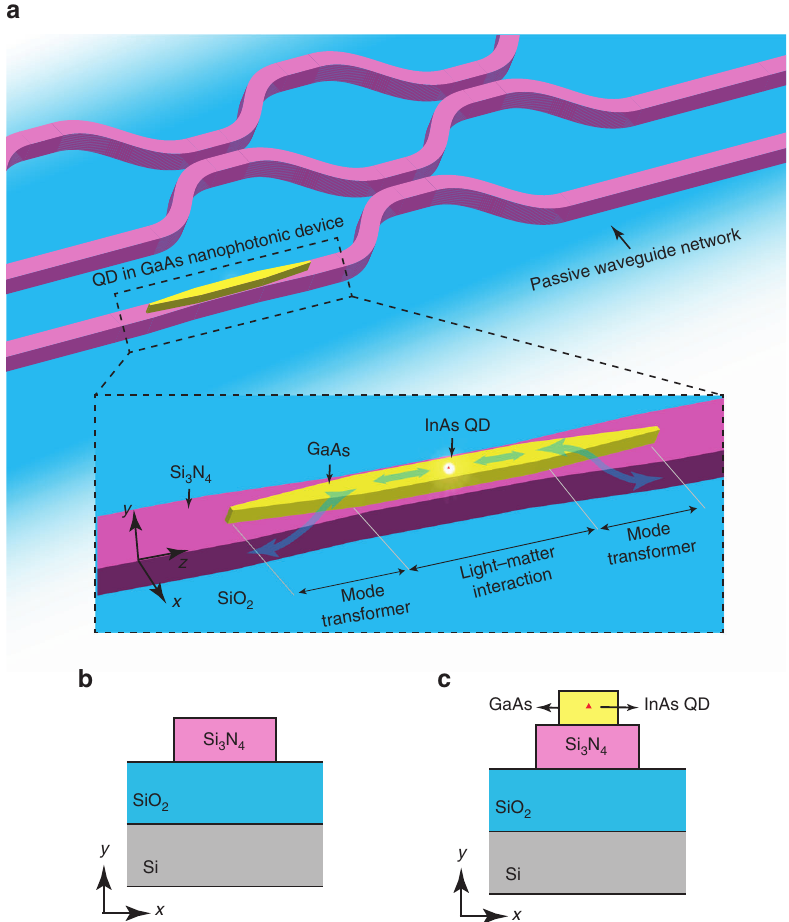
Fig. 1 Principle of operation and device geometry. a Conceptual quantum photonic circuit composed of a passive waveguide network with a directly integrated GaAs nanophotonic device (exempli fi ed by a nanowaveguide) containing a single quantum dot. A zoomed-in image of the GaAs device region (inside the dashed boundary box) shows details of the geometry and operation principle of the hybrid photonic integration platform. The light – matter interaction section of the device promotes ef fi cient coupling between a con fi ned electromagnetic fi eld (in this case, a wave con fi ned in a GaAs nanowaveguide) and a single-InAs QD embedded in the GaAs. Adiabatic mode transformers allow light from the QD in the light – matter interaction region to be ef fi ciently transferred to a Si 3 N 4 waveguide, and, conversely, also allow the QD to be accessed ef fi ciently with resonant light guided by the Si 3 N 4 waveguide. b , c Cross-sections of passive Si 3 N 4 and active GaAs waveguides that form the core elements of the integration